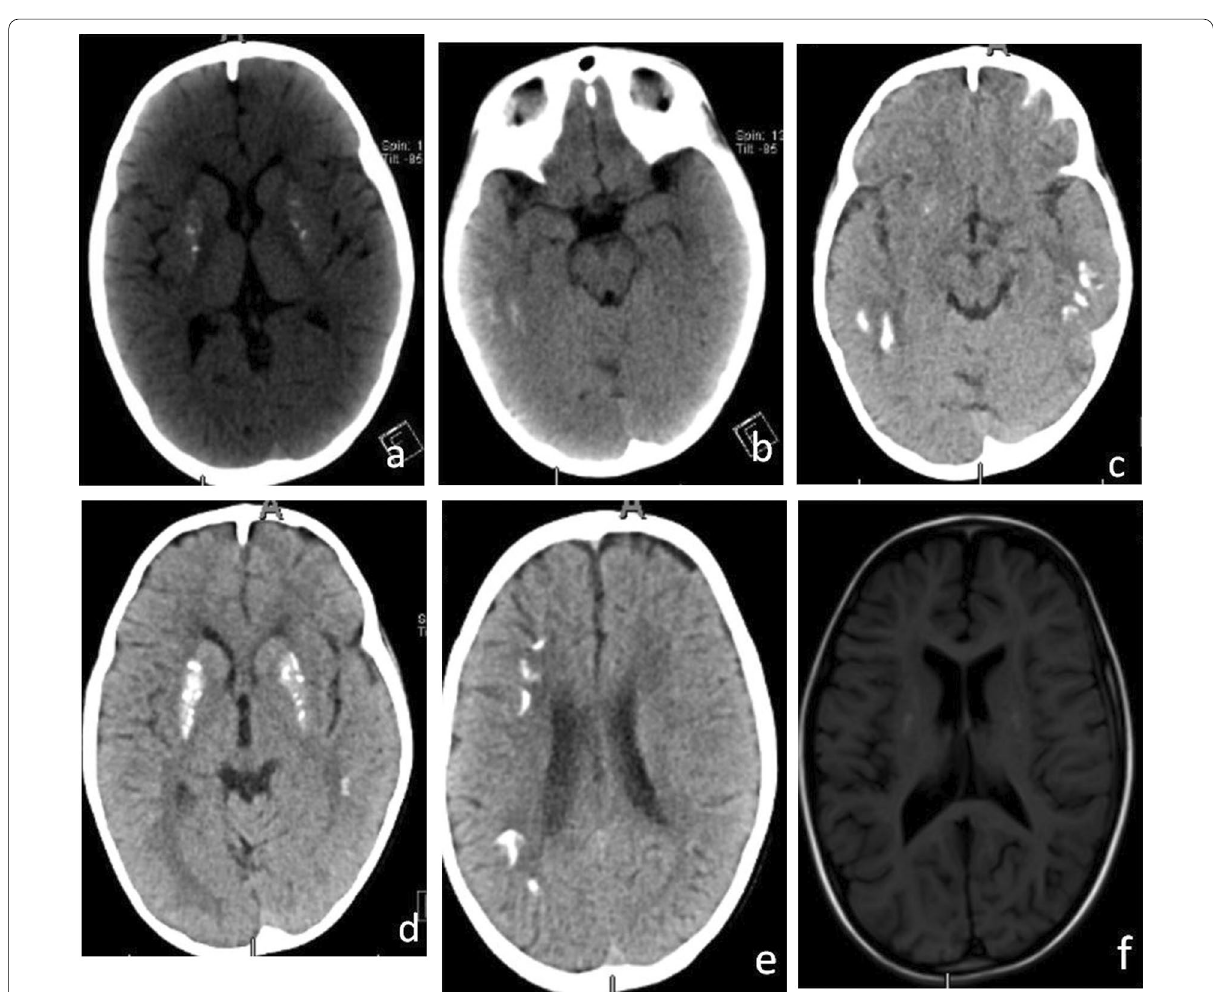
Fig. 1 A 9-year-old male patient with acute lymphocytic leukemia, CT a , b shows faint calcifications located at the basal ganglia bilaterally and right temporal lobe. Follow-up CT 3 years later c , d and e shows progression of the basal ganglia calcifications, newly developed asymmetrical frontal and parietal as well as temporal subcortical calcifications. Axial T1WI f only detected bright signal at the basal ganglia bilaterally and the subcortical calcifications are hardly